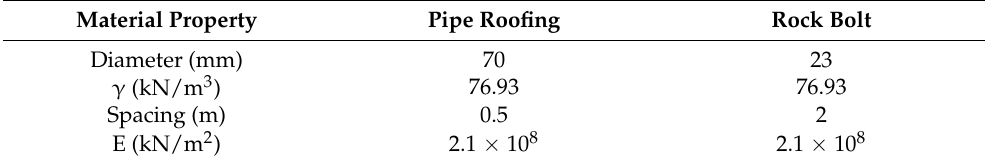
Table 3. Parameters of the pipe roofings and rock